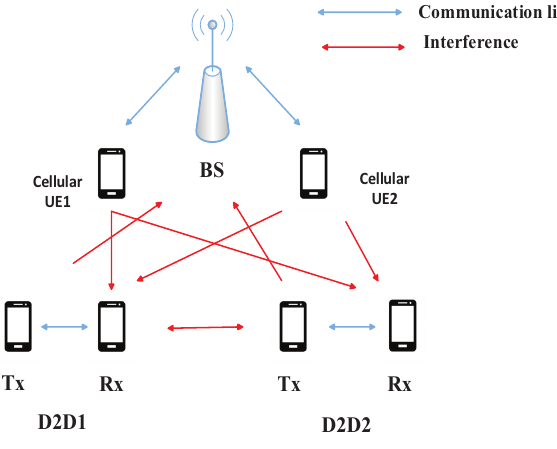
Figure 1: System model of D2D communications with uplink channel